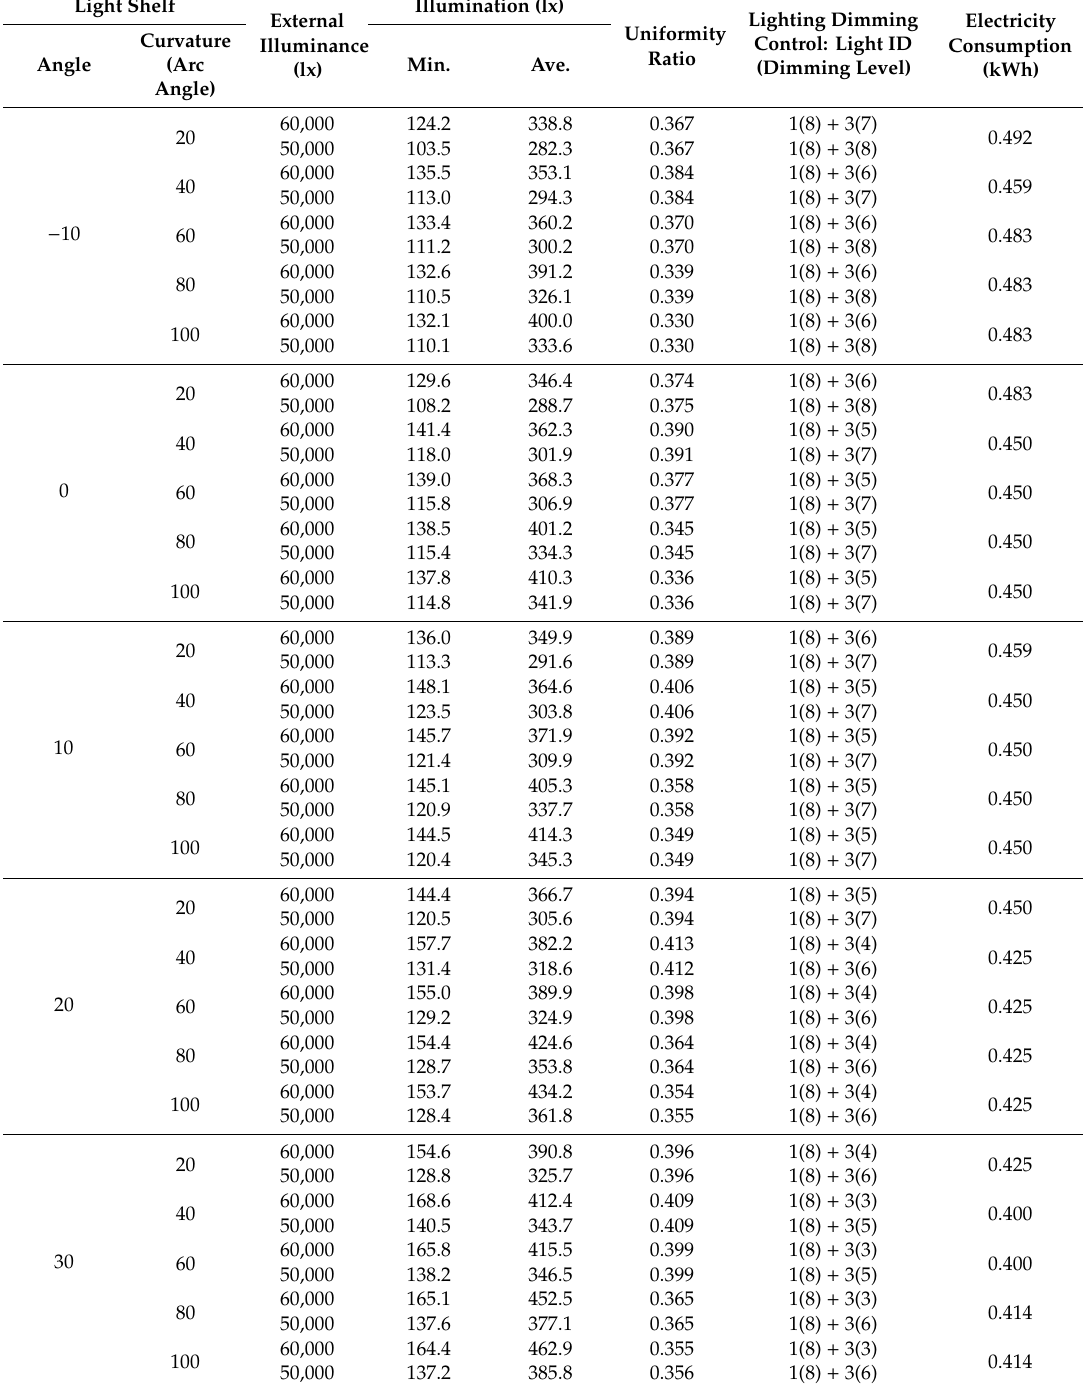
Table 9. Performance evaluation results for curved light shelf during